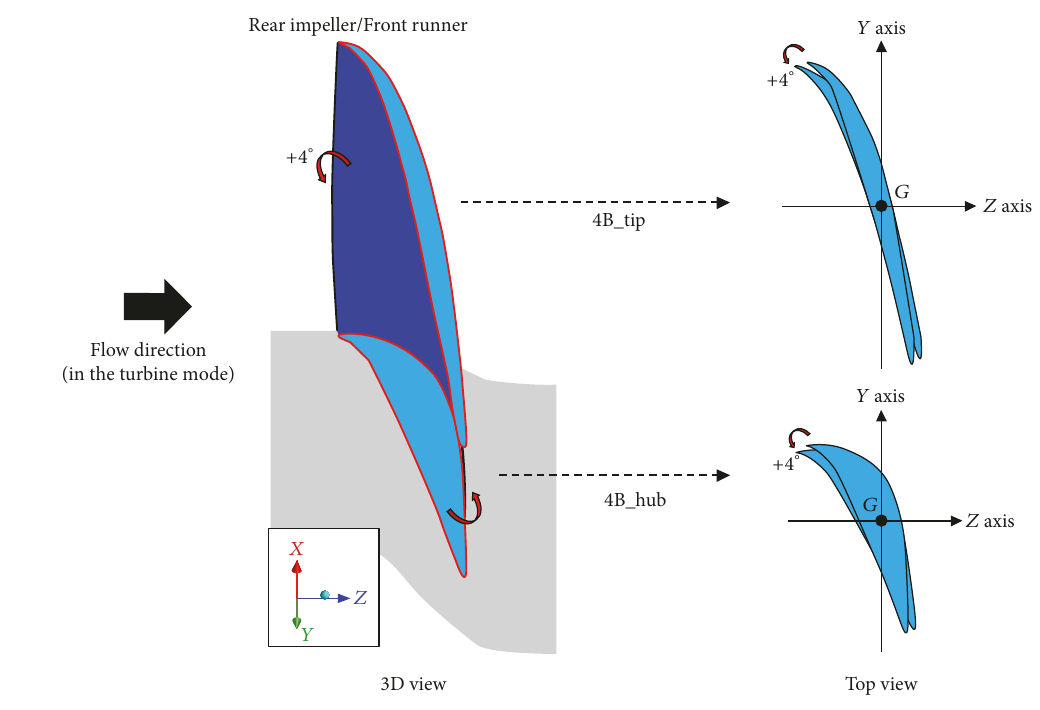
Figure 4: Definition of the design variables. Table 3: Results of the multiobjective